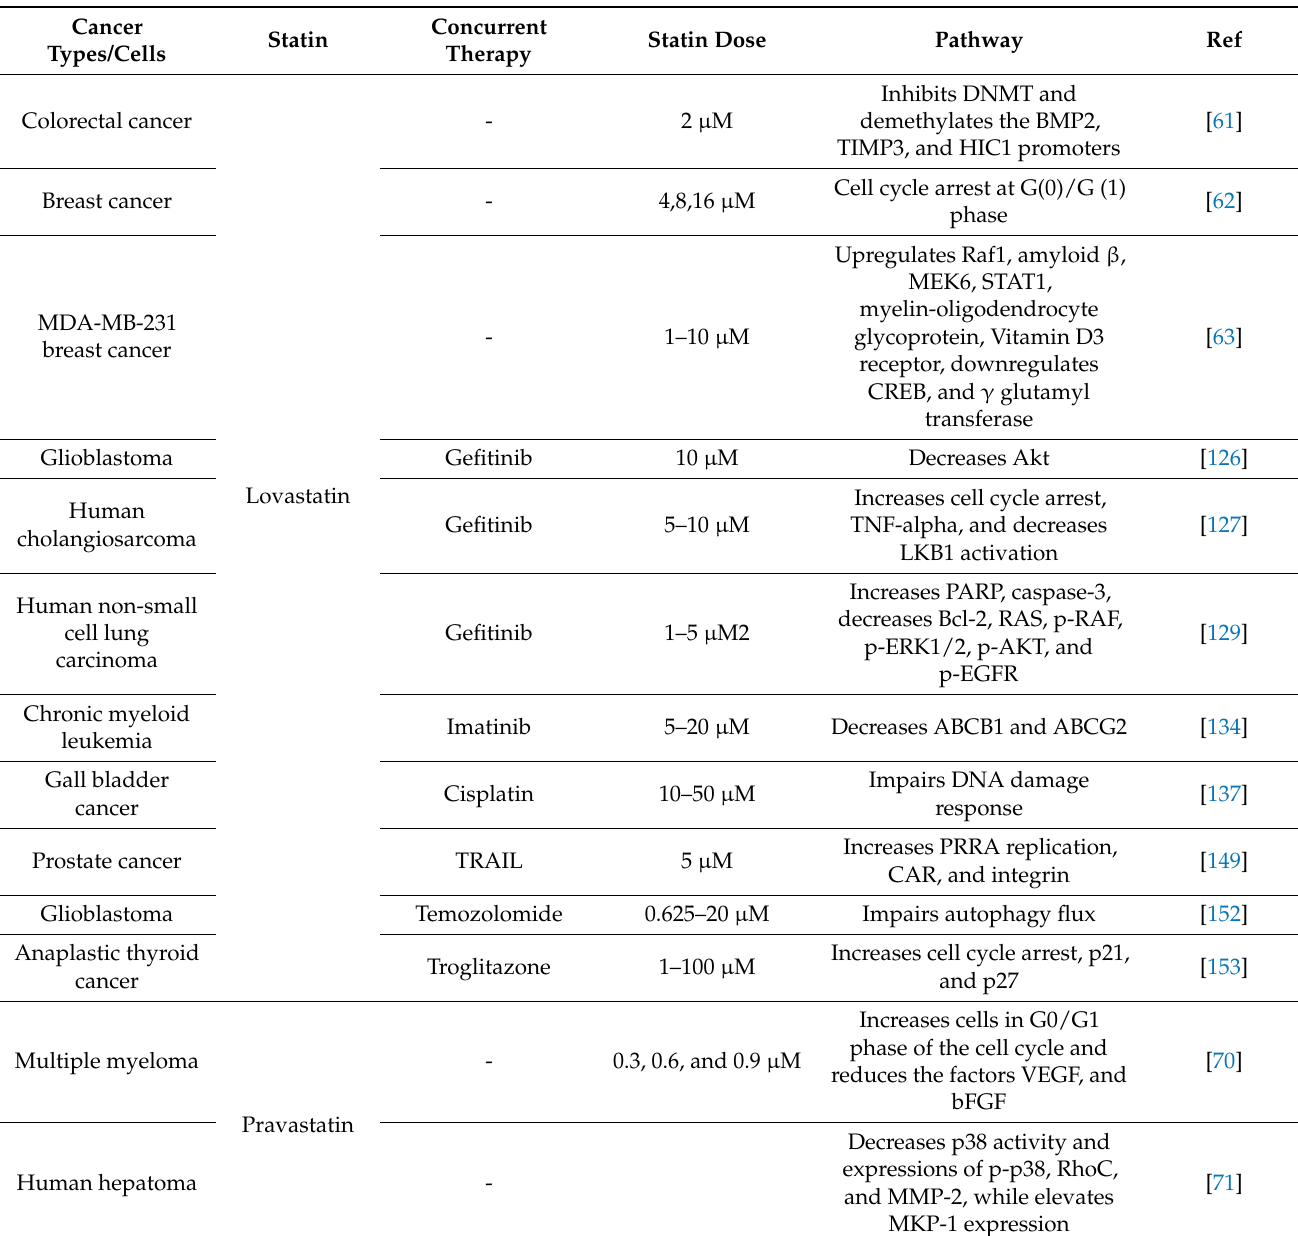
Table 2. In vitro study of statins showing the synergistic action in combination with anti-cancer drugs to overcome anti-cancer therapy